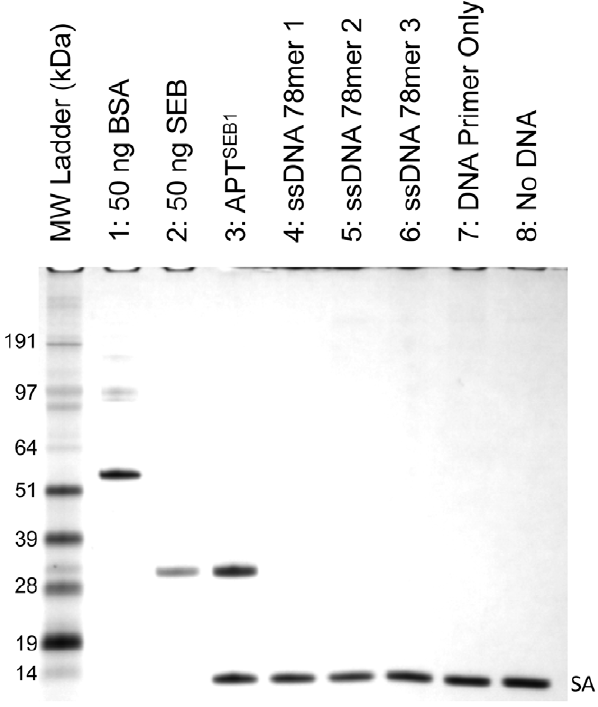
Figure 1. APT SEB1 binds to SEB, but not BSA. Aptamer- precipitation of SEB from 10-fold excess of BSA using several DNA sequences was visualized by 4–12% SDS-PAGE with silver stain. Dynabeads H M-270 Streptavidin magnetic beads coated with APT SEB1 (lane 3), random 78-base ssDNA (lanes 4–6), PCR forward primer (used in this study, lane 7), and nothing (lane 8), were incubated in 500 m l PBS-T incurred with 10 m g BSA and 1 m g SEB. After washing the Dynabeads with PBS-T, the protein eluate (lanes 3–8) was loaded